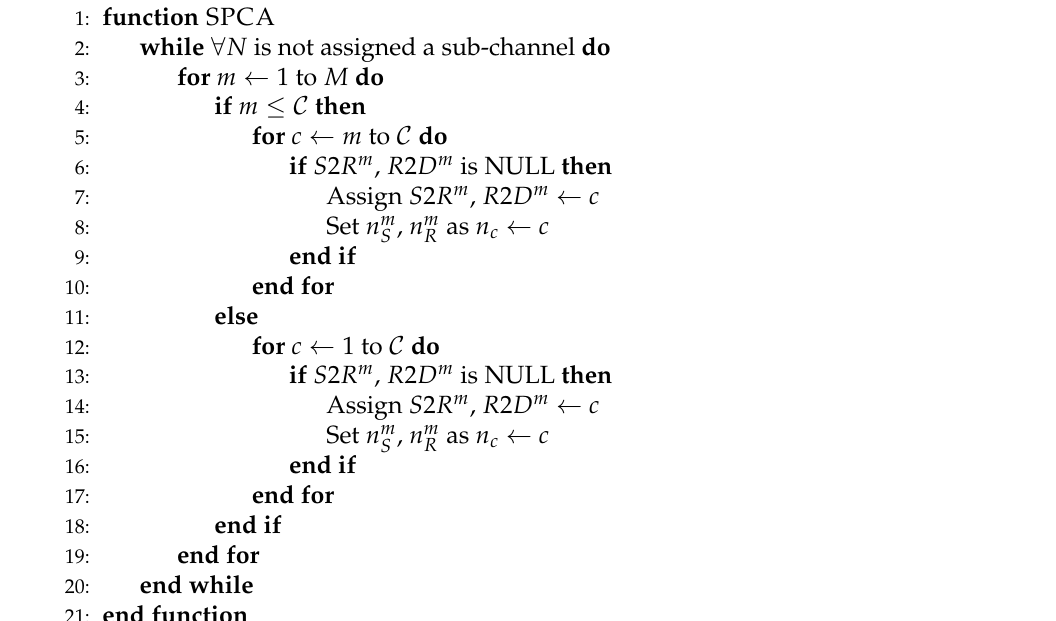
Algorithm 2 SR Pairing Channel Allocation